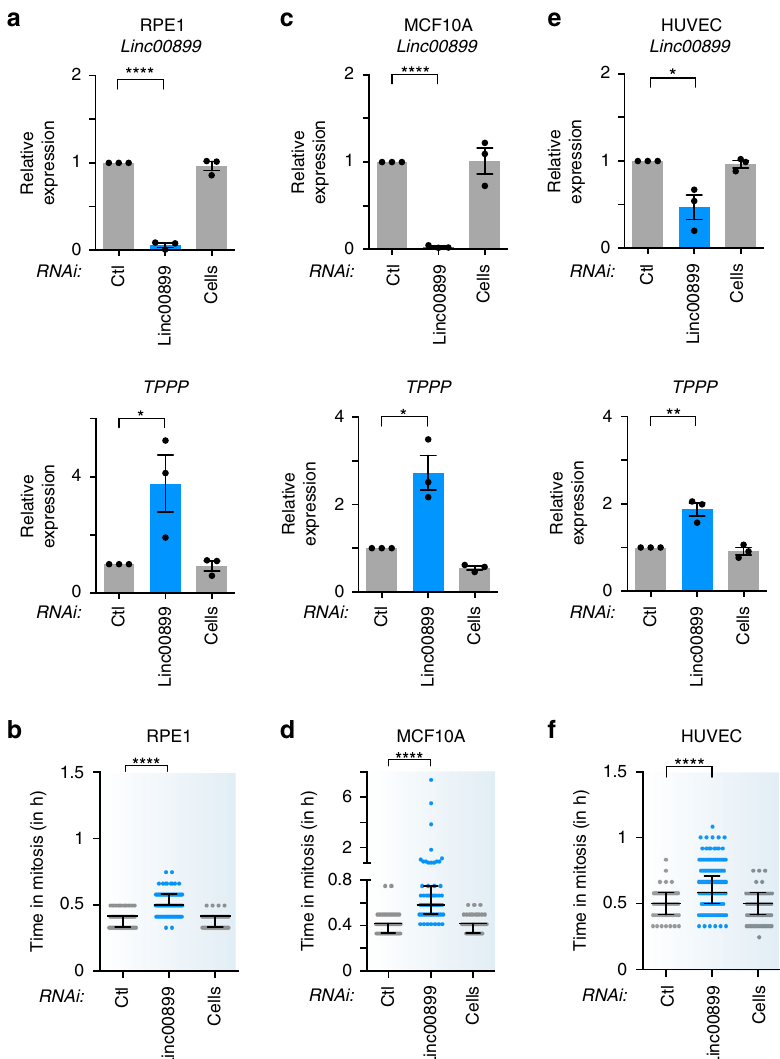
Fig. 7 Linc00899 regulates TPPP and mitotic progression in different cell lines. a Expression of linc00899 and TPPP after RNAi-mediated depletion of linc00899 in normal retina cell line (hTert-RPE1) based on qPCR. Results are also shown for negative control siRNAs (Ctl, from Ambion) and cells treated with transfection reagent alone (Cells). n = 3 biological replicates, * P < 0.05 and **** P < 0.0001 by two-tailed Student ’ s t test. b Quanti fi cation of